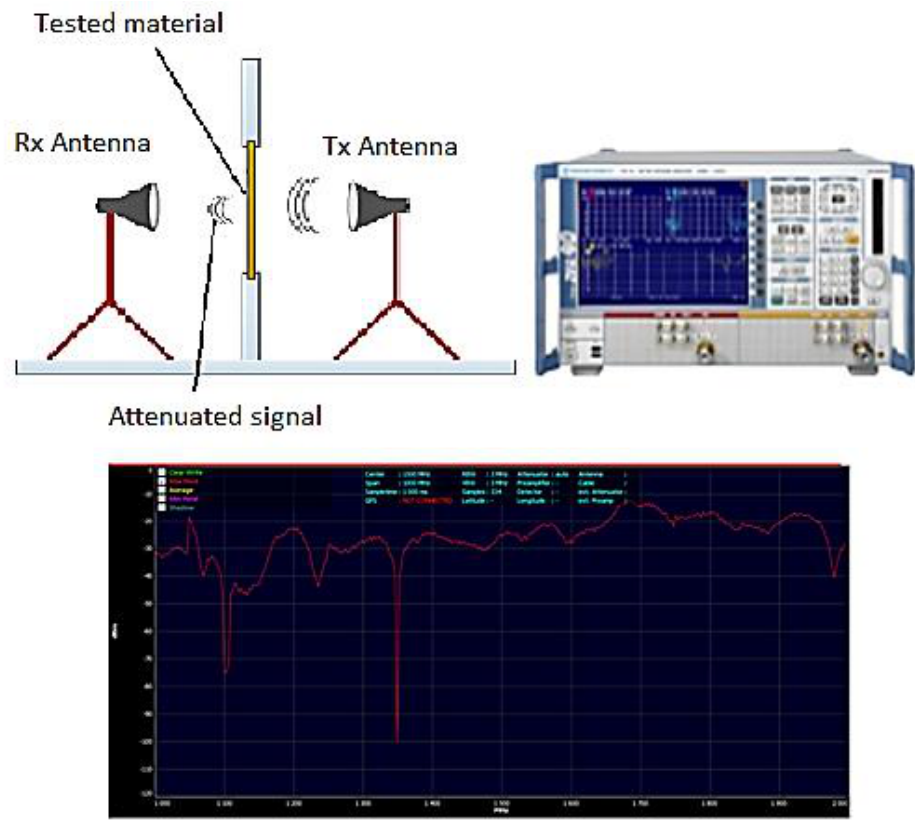
Figure 2. The Rohde & Schwarz measuring setup for EMI-shielding effectiveness.